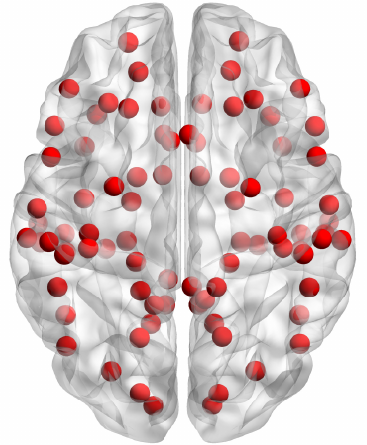
Figure 2. Red points denote the 84 ROIs